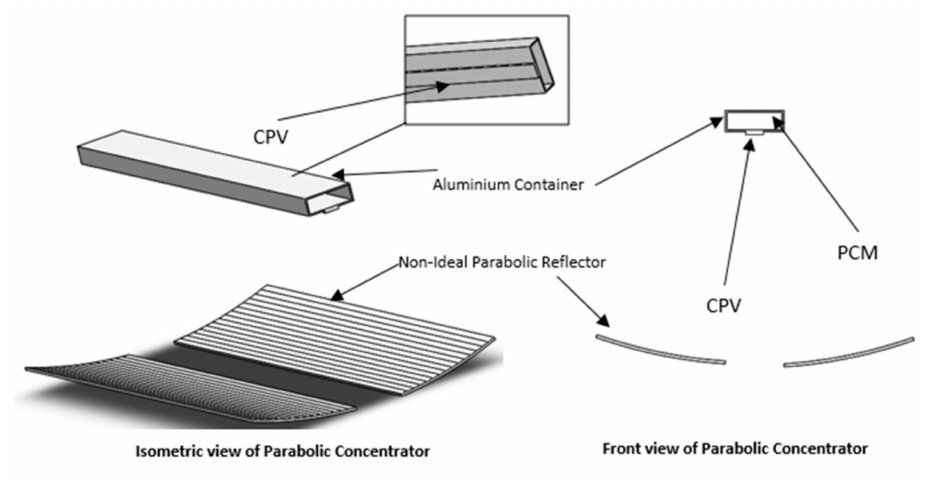
Figure 7. CAD model of non-ideal parabolic